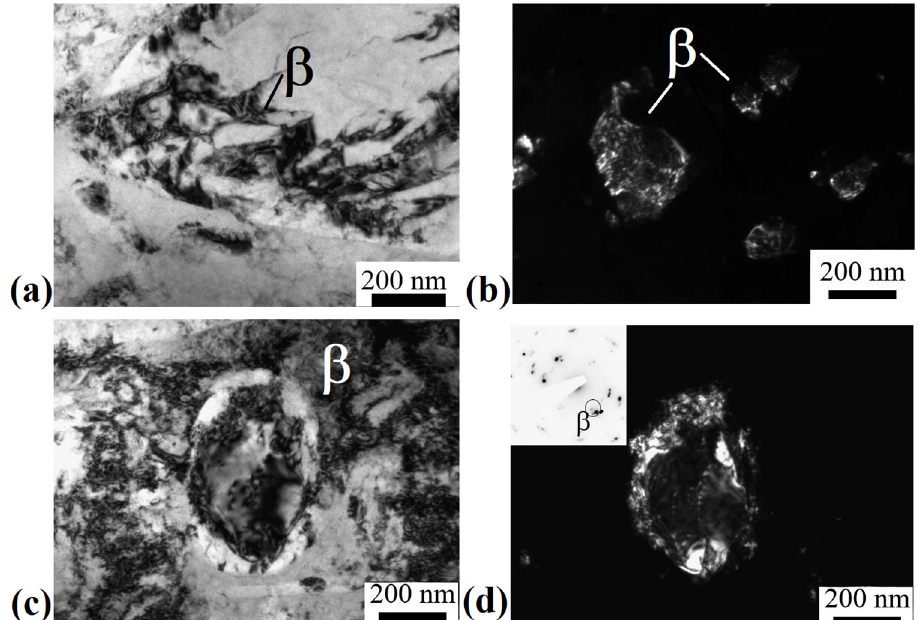
Figure 4. Microstructure of the alloy after ECAP-C, longitudinal section, TEM: ( a ) fragmented β -grain; ( b ) dark-field image of β -grains subjected to deformation; ( c ) bright field image of a recrystallized β grain; ( d ) dark field image of a recrystallized β grain.